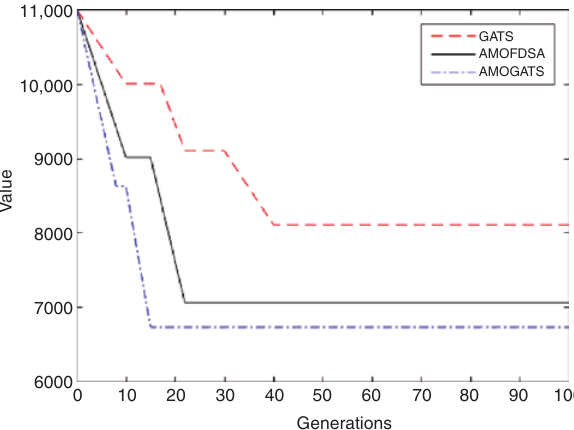
Figure 9: Results of AMOGATS, AMOFDSA, and GATS.